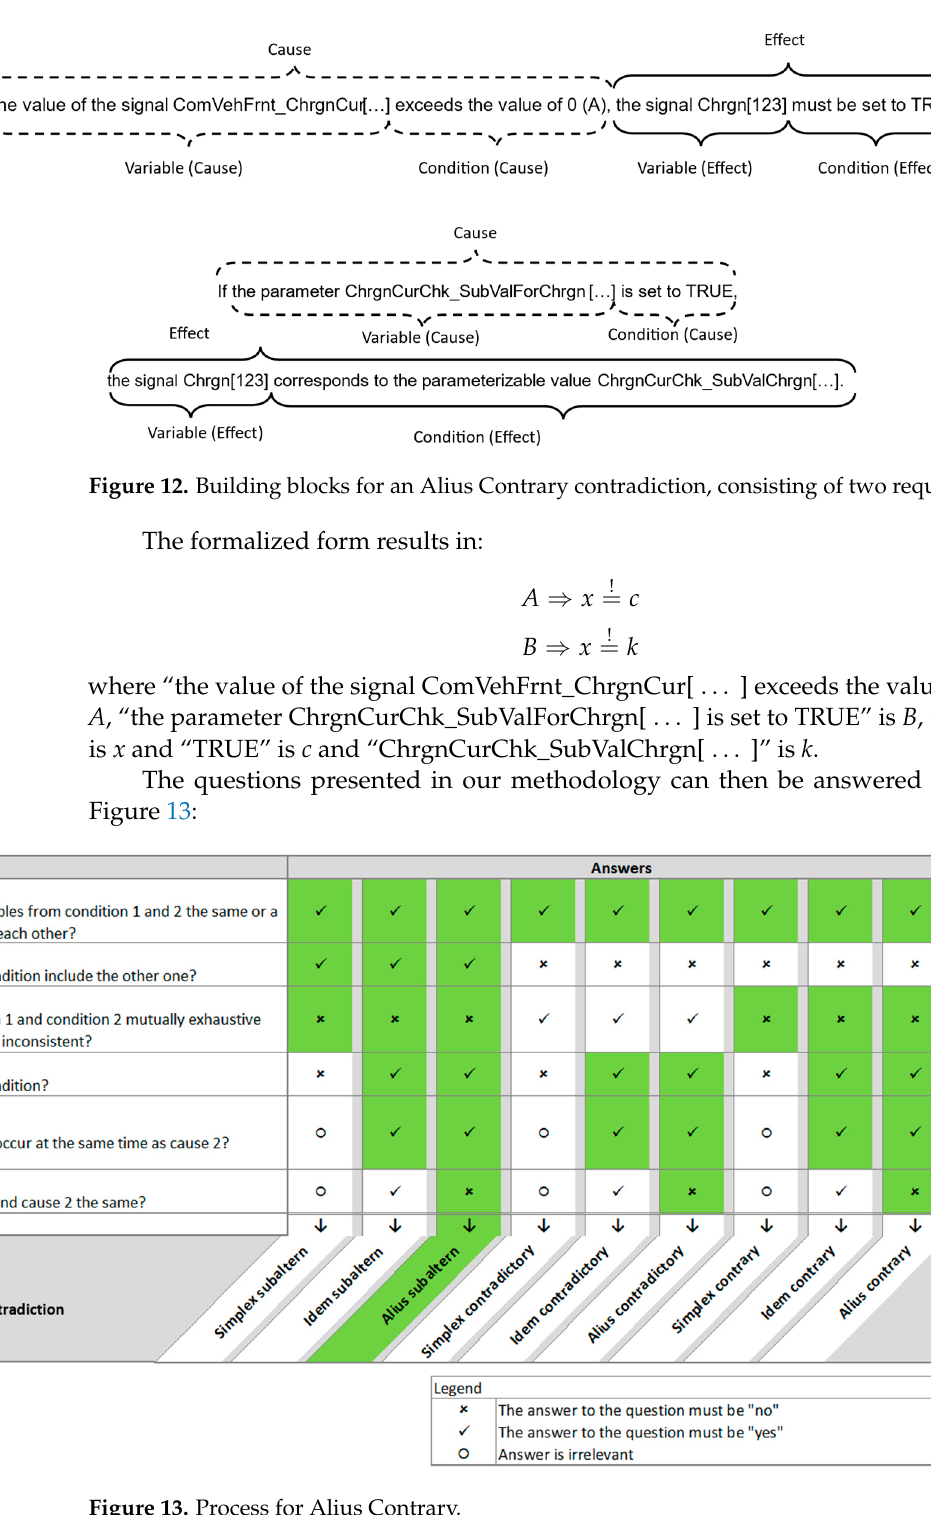
Figure 13. Process for Alius